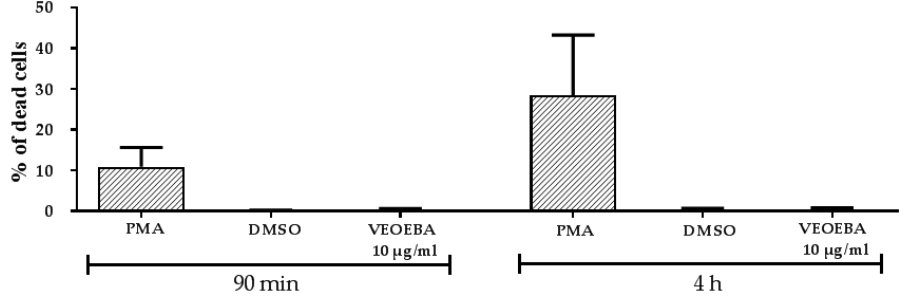
Figure 5. VEOEBA does not induce the death of neutrophils after 90 min or 4 h of incubation, tested by trypan blue staining and subsequent quantification of the stained cells compared to total amount of neutrophils per field of view, from n = 3 independent experiments. * p < 0.05 one-tailed, unpaired Student’s t